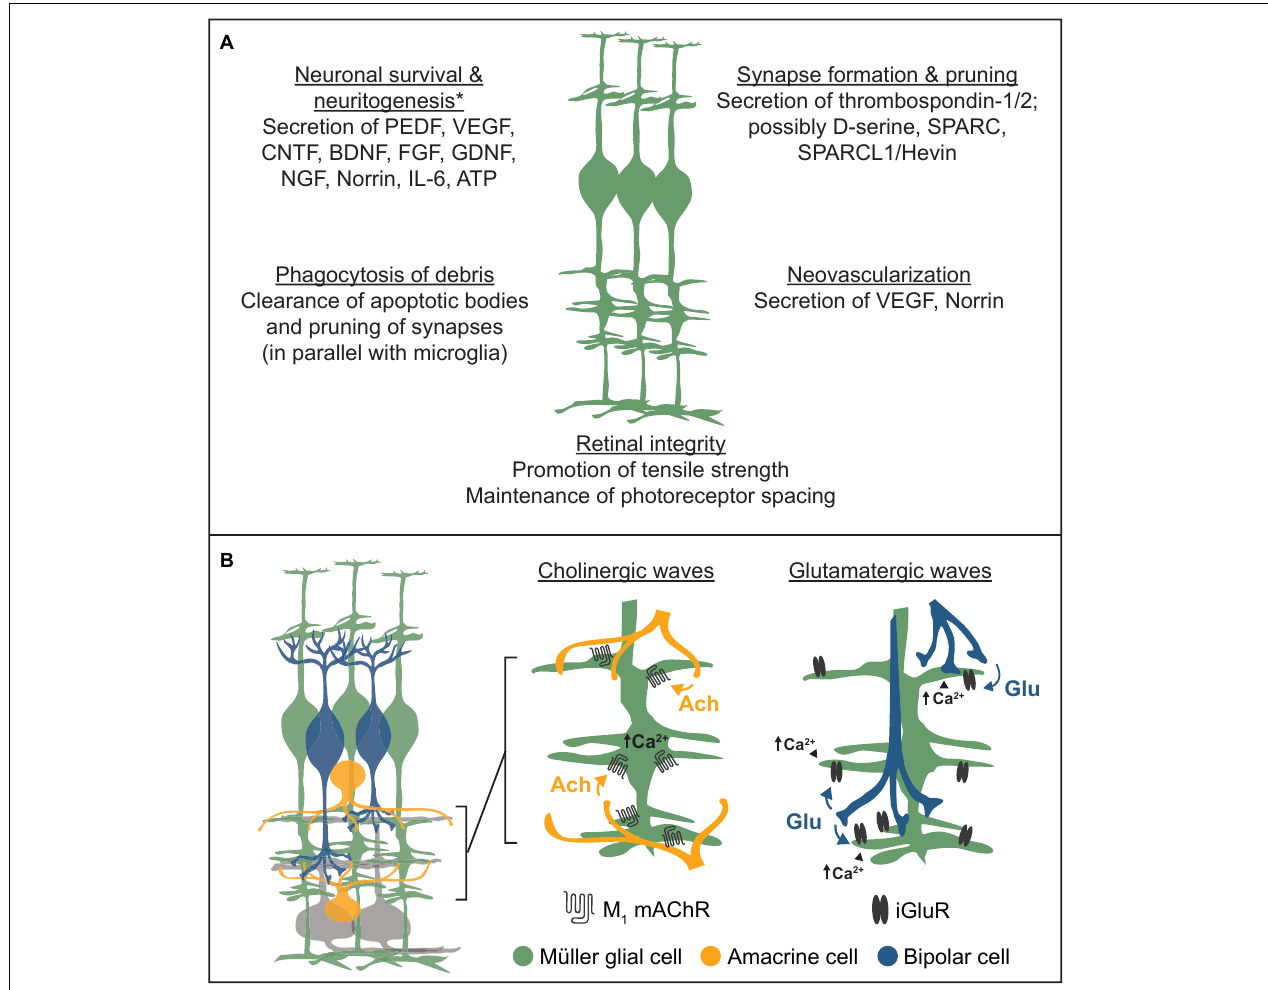
FIGURE 6 | Summary of the roles of Müller glia in retinal development. (A) Müller glia engage in broad aspects of retinal development through the release of neurotrophins, synaptogenic proteins, and other trophic factors, while also clearing cellular debris and maintaining retinal integrity. Examples listed are non-exhaustive. *Müller glia-derived trophic factors promoting neuronal survival or neuritogenesis were primarily identified in neuron-glia coculture experiments. (B) Summary of Müller glial responses to cholinergic and glutamatergic retinal waves. Left , schematic diagram of basic inner retinal circuits showing bipolar cells (blue), Müller glia (green), amacrine cells (orange), and ganglion cells (gray) intermingling within the inner plexiform layer (IPL). Middle , during cholinergic retinal waves, starburst amacrine cells spontaneously release acetylcholine (ACh), which activates Müller glial M 1 muscarinic acetylcholine receptors (mAChRs) following spillover from synapses. This induces calcium transients in Müller glia primarily localized to their stalks within the inner plexiform layer. Right , during glutamatergic retinal waves, bipolar cells spontaneously release glutamate (Glu), which activates Müller glial ionotropic glutamate receptors (iGluRs) following synaptic spillover, inducing calcium transients primarily localized to glial lateral processes within the